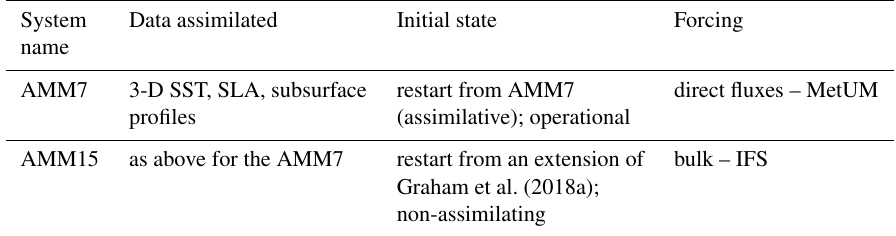
Table 6. Summary of the trial